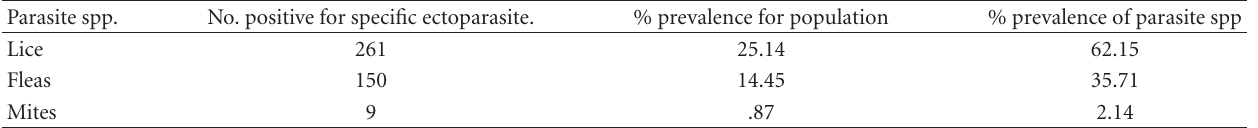
Table 2: Prevalence of ectoparasite species in the population, n = 427. Parasite